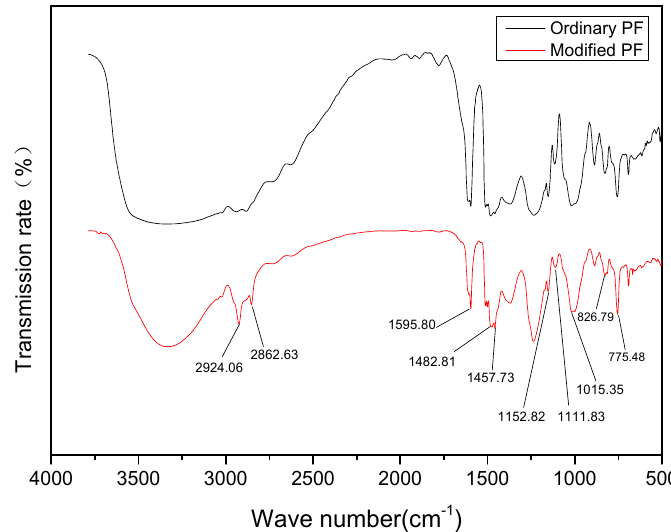
Figure 1. The FT-IR spectra of the ordinary PF and modified PF (the amount of 3-pentadecyl-phenol is 15% of the total amount of phenol).